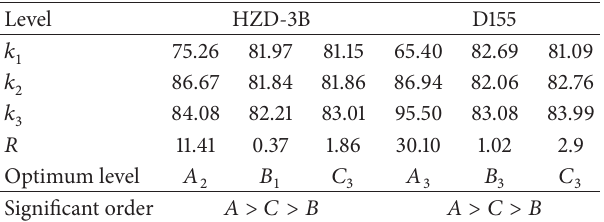
Table 4: The analysis of orthogonal extremum. 𝑘 1 , 𝑘 2 , and 𝑘 3 are the averagevaluesofthreelevels. 𝑅 isthedeferencebetweenextremums.